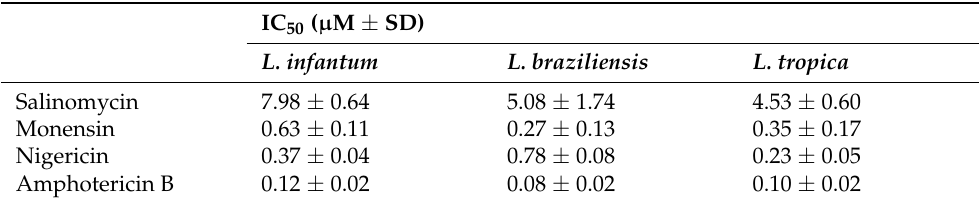
Figure 1. Dose-response curves of the effect of salinomycin, monensin, and nigericin on the growth of promastigotes of L. infantum ( A ), L. braziliensis ( B ), and L. tropica ( C ). Each point represents the mean ± SD from one representative experiment in duplicate out of three conducted in the same conditions. Table 1. IC 50 values of salinomycin, monensin and nigericin against L. infantum , L. braziliensis , and L. tropica promastigotes.